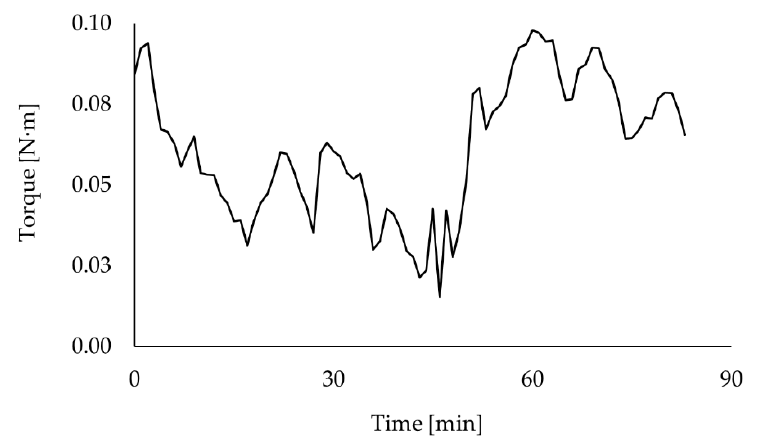
Figure A4. Experimental torque of the continuous abiotic system.